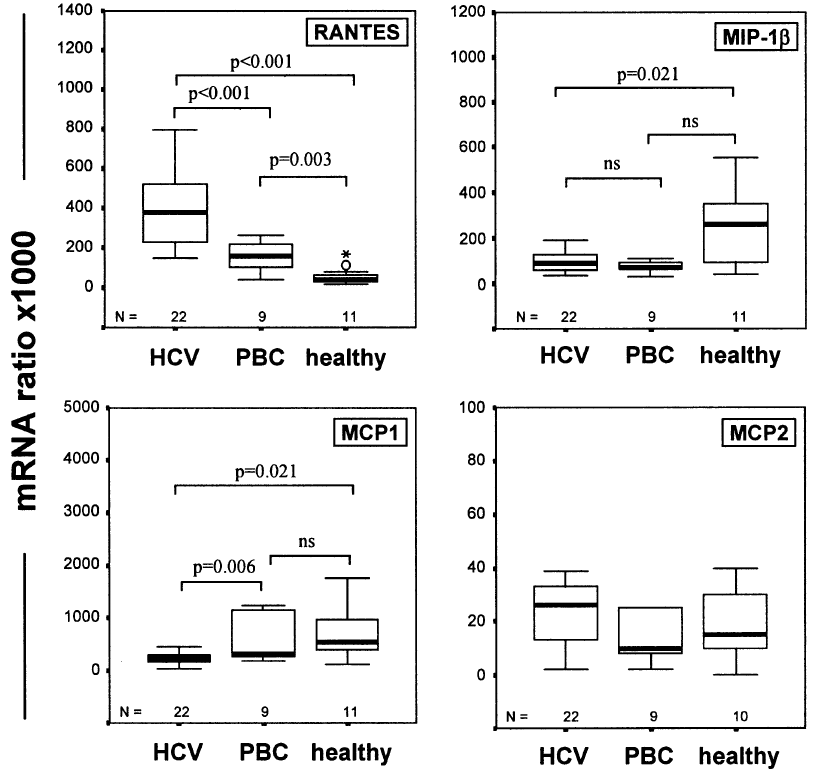
FIG. 1. Semiquantitative determination of intrahepatic steady-state mRNA levels in HCV infection. CC chemokine mRNA levels were detemined in liver specimens from patients with chronic hepatitis C (n (cid:3) / 22), PBC (n (cid:3) / 9) and normal controls (n (cid:3) / 12). Results of semiquantitative determination of intrahepatic steady-state mRNA levels of RANTES (upper left), MIP-1 b (upper right), MCP1 (lower left), and MCP2 (lower right) in liver specimens from patients with chronic hepatitis C (n (cid:3) / 22), primary biliary cirrhosis (n (cid:3) / 9) and normal controls (n (cid:3) / 12). As shown we found significantly increased levels of RANTES mRNA but decreased levels of MIP-1 b and MCP1 in livers from HCV-infected patients as compared with the control groups. Data presented as boxplots showing median, quartiles and extreme values; pvalues presented as calculated with Mann (cid:1) / Whitney